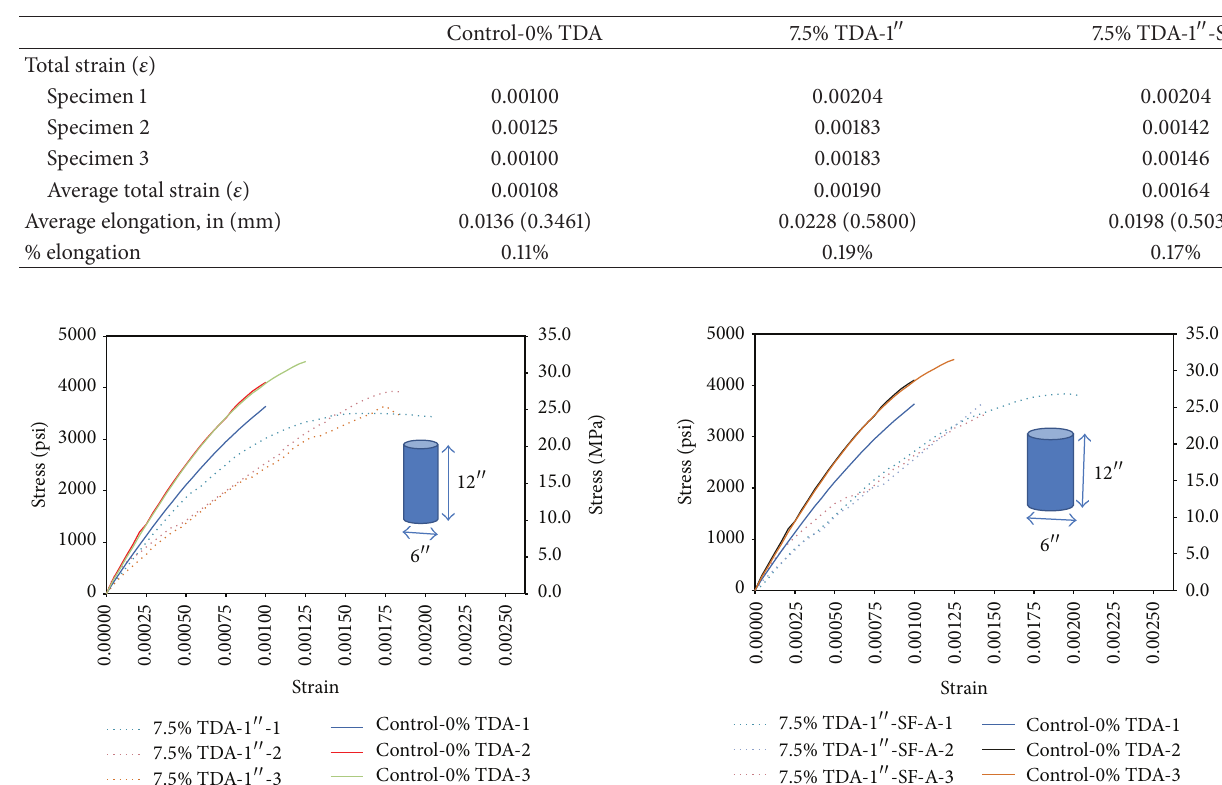
Table 4: Total strain deformation comparison for the different types of concrete.